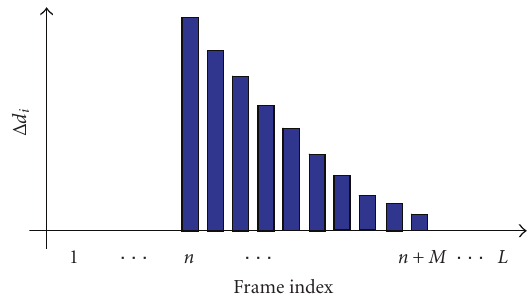
Figure 4: Error propagation for a single frame